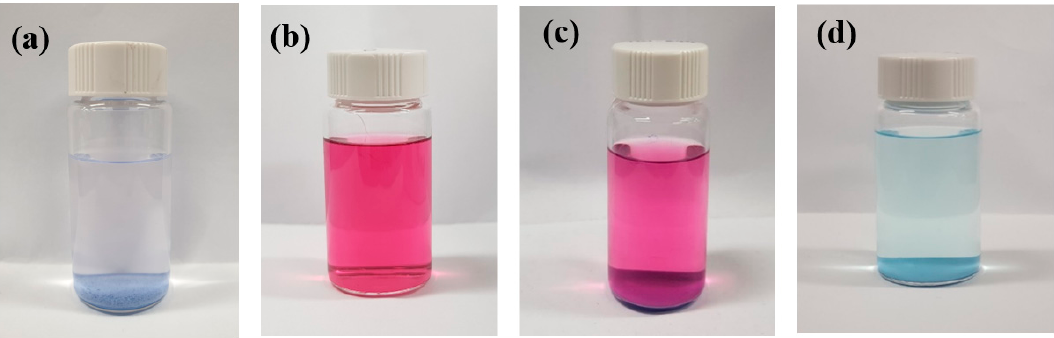
Figure 2. Photos of solutions of ( a ) CoCl 2 in HTFA at rt, ( b ) [Me 4 N] 2 CoCl 4 -in HTFA at rt, ( c ) [Me 4 N] 2 CoCl 4 -catalyzed methane oxidation for 30 min, and ( d ) for 1 h. To understand the catalyst form in HTFA in the [Me 4 N] 2 CoCl 4 -catalyzed reaction, the HTFA solvent was removed by vacuum from the pink solution after the reaction, and a pink powder was obtained. Characterization of the obtained pink solid using XPS, IR, and elemental analysis revealed the isolated solid was [Me 4 N] 2 CoTFA 4 , suggesting CoCl 42 − was turned into CoTFA 42 − in